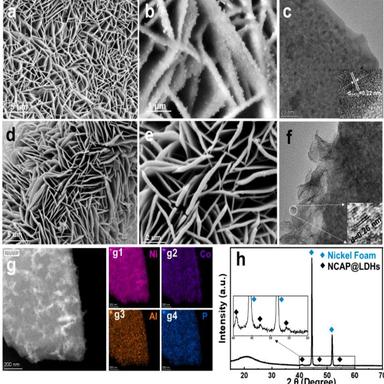
SEM (a and b), TEM (c and inset) images of NCAP. SEM (d and e), TEM (f and inset), HAADF and elements mappings (g, g1–g4), full (h), and partial XRD patterns (inset) of NCAP@LDHs.